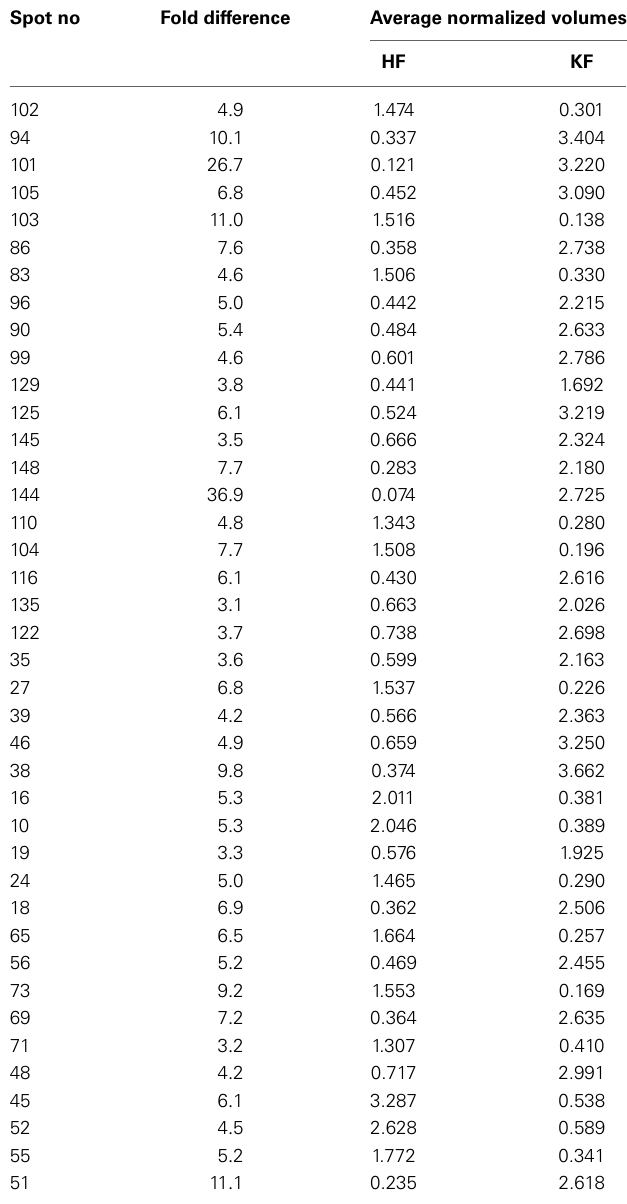
Table 1 | Differentially expressed spots in the DIGE gel of spermatogenic cells (HF × KF) analyzed using the Decyder™